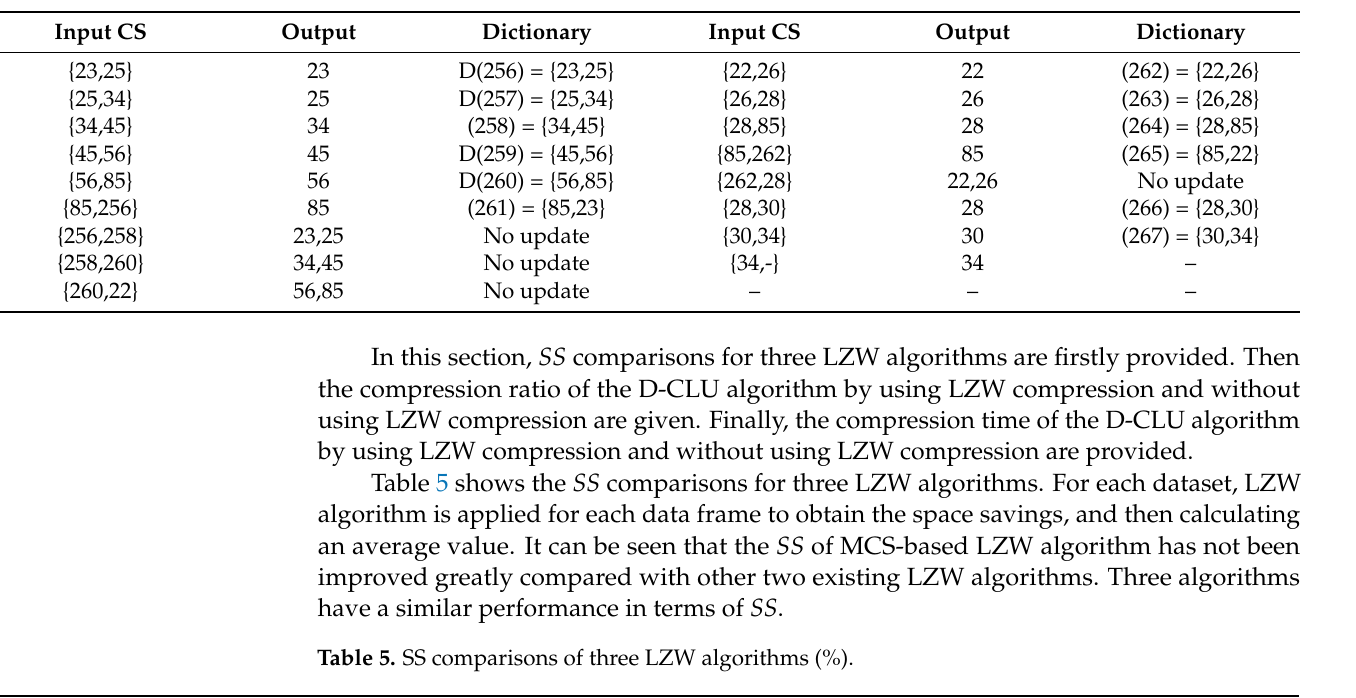
Table 4. Decoding process of the MCS-based LZW algorithm.